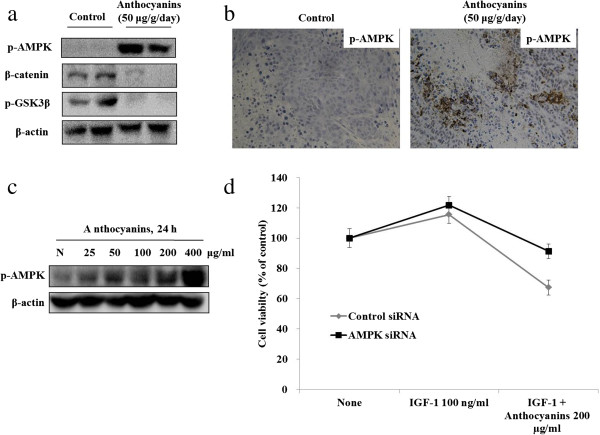
Anthocyanins regulate GSK3β, β-catenin and AMPK in vivo and AMPK in vitro. (a) Mice were sacrificed and tumor extracts were subjected to Western blot analysis for quantification of p-GSK3β and β-catenin levels. (b) The level of p-AMPK was also measured by immunohistochemical analysis. (c) Cells were treated with anthocyanins (25–400 μg/ml) for 24 h and total proteins were subjected to Western blot analysis using antibodies against phospho-AMPK and β-actin (loading control). (d) Cells were transiently transfected with AMPK siRNA or non-specific siRNA (control) for 72 h, treated with anthocyanins for 48 h, and assessed for viability using the MTT assay. Cell viability was calculated as a percentage of viable control siRNA-transfected cells.